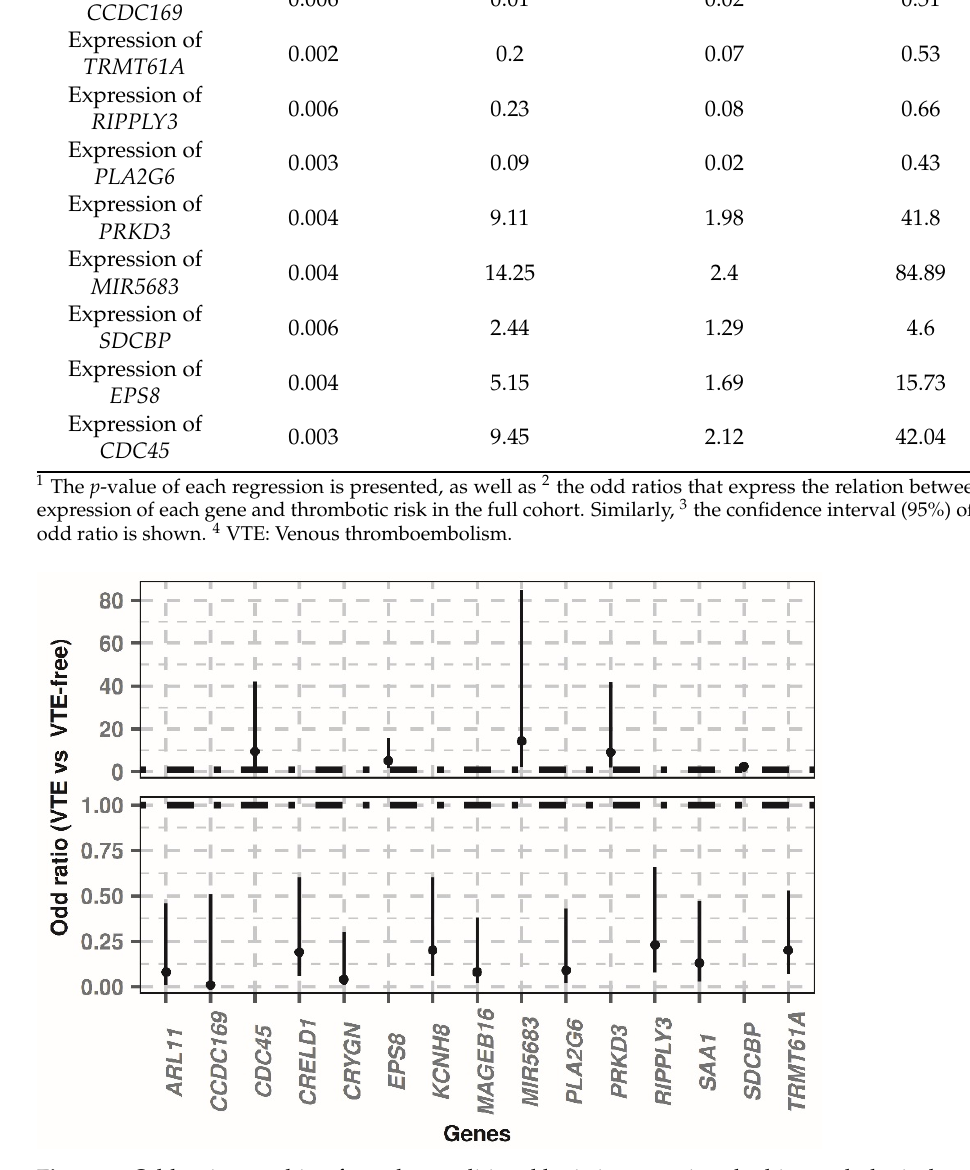
Figure 2. Odd ratios resulting from the conditional logistic regressions by histopathological stratum. The black and dashed line by dot–dash indicates the 1 value on both Y-axis sections. The odd ratios above 1 on this axis indicated that the greater the gene expression, the greater associated thrombotic risk in the overall cohort, whereas values of less than 1 indicated that the greater the expression, the lower the associated risk. In the 15 genes, the confidence intervals (vertical black solid lines) of the odd ratios do not cross the value of 1, which points to all the regressions being significant. VTE: Venous thromboembolism.